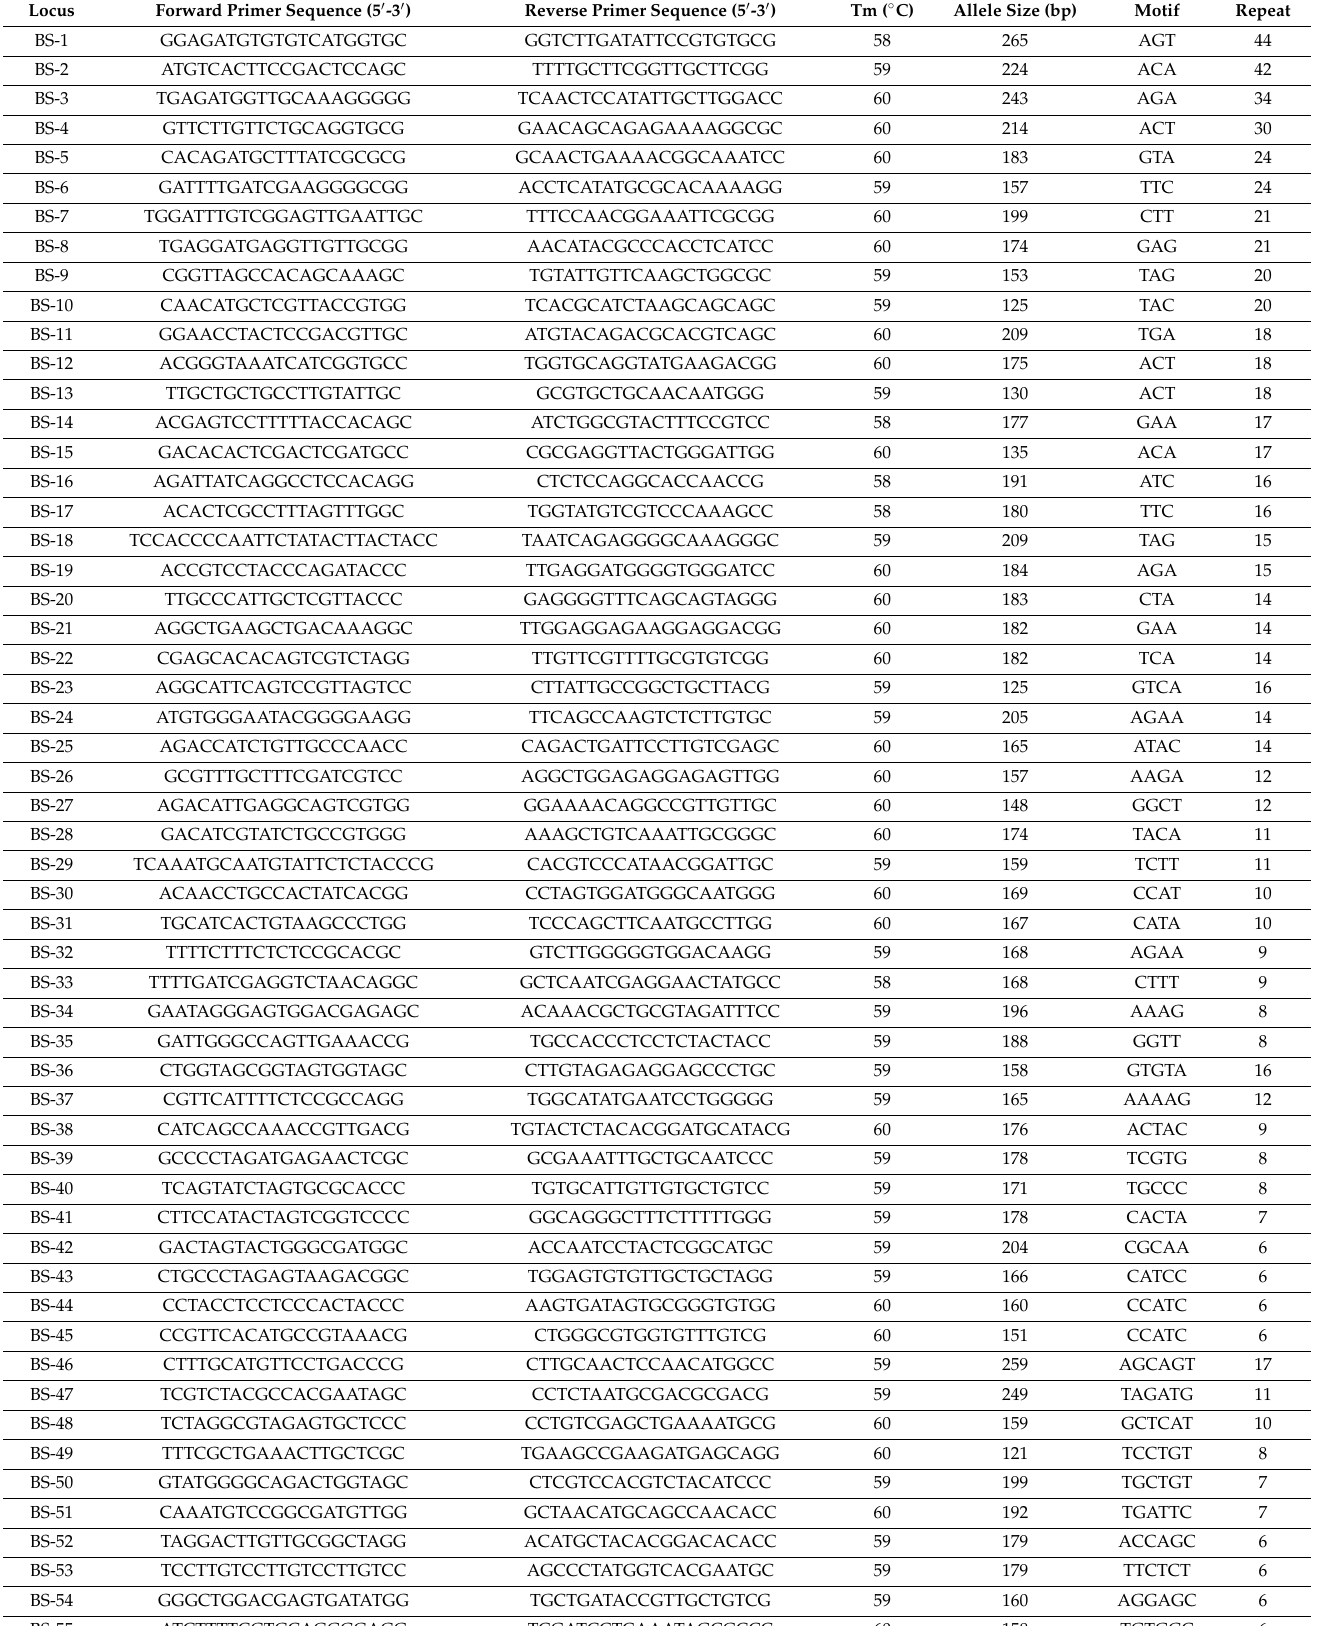
Table 1. Characteristics of 55 polymorphic microsatellite markers developed in this study for popula- tion genetic diversity analysis of Bipolaris sorokiniana